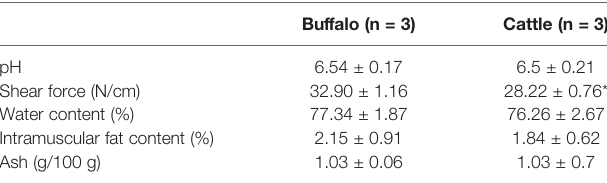
TABLE 1 | Phenotypic parameters measured in longissimus dorsi samples.